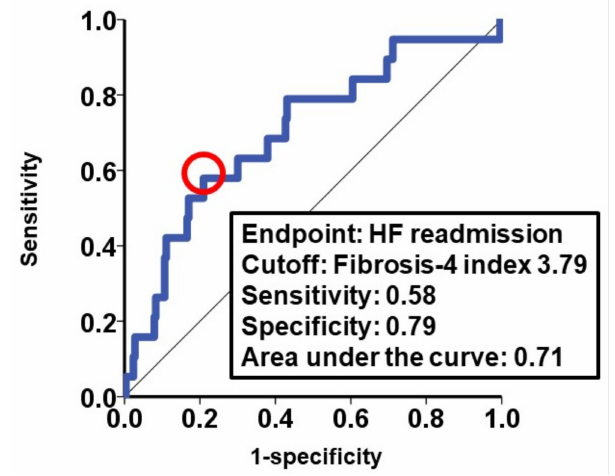
Figure 2. Cutoff of fibrosis-4 index for the primary endpoint. HF, heart failure. Cutoff was calculated as 3.79 of the fibrosis-4 index.